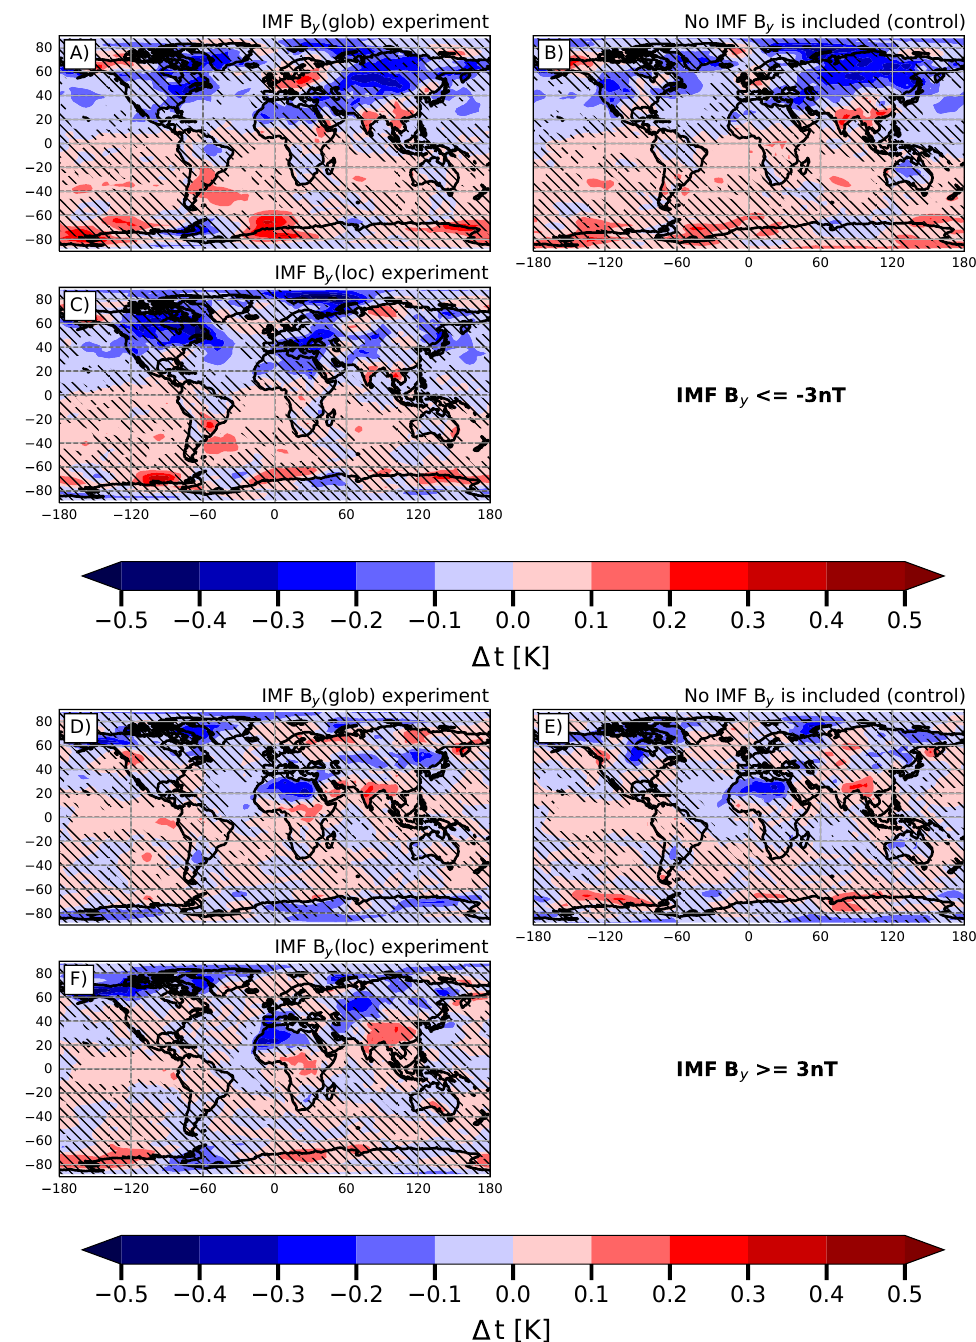
Figure 6. Ensemble-mean geographical distribution of ∆ t averaged for the interval 1999–2002. Panels A, B, and C: ∆ t averaged over days with daily-mean IMF B y ≤ − 3 nT from B y (glob) ( A ), control ( B ), and B y (loc) ( C ) experiments; panels D, E, and F: ∆ t averaged over days with daily-mean IMF B y ≥ 3 nT from B y (glob) ( D ), control ( E ), and B y (loc) ( F ) experiments. Hatches represent the probability of anomalies less than 95%.